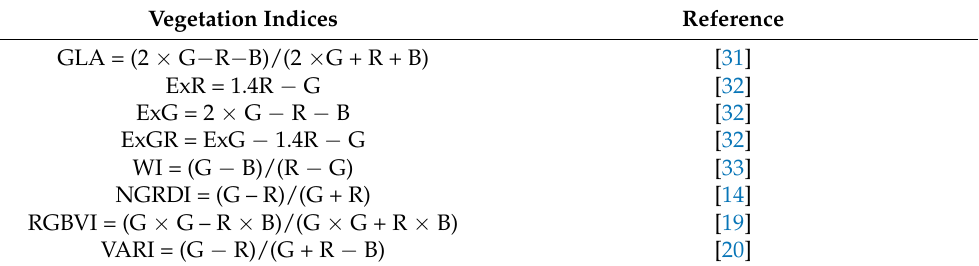
Table 2. Indices calculated based on the unmanned aerial vehicle (UAV) images in this study. Vegetation Indices